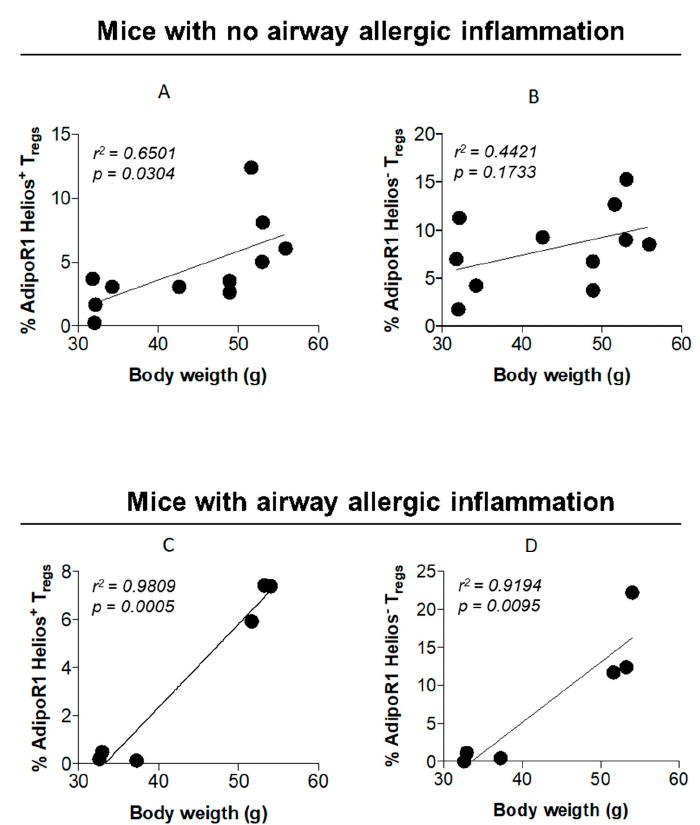
Figure 7. The AdipoR1 expression in lung Tregs was correlated with the grade of obesity during allergic inflammation. Scatter graphs showing the correlation analysis between the AdipoR1 expression in Helios + ( A ) and Helios − ( B ) Tregs and the body weight in naïve (non-allergic lung inflammation) mice on HFD at 15, 21, and 26 weeks of age, and Helios + ( C ) and Helios − ( D ) in allergen-induced airway inflammation model in mice on HFD at 15 and 26 weeks of age. Data are means ± SEM of n = 6–11 mice per group. r 2 , Pearson correlation coe ffi cient; HFD, high-fat diet; AdipoR1, adiponectin receptor 1; Tregs, regulatory T cells; and Hel,